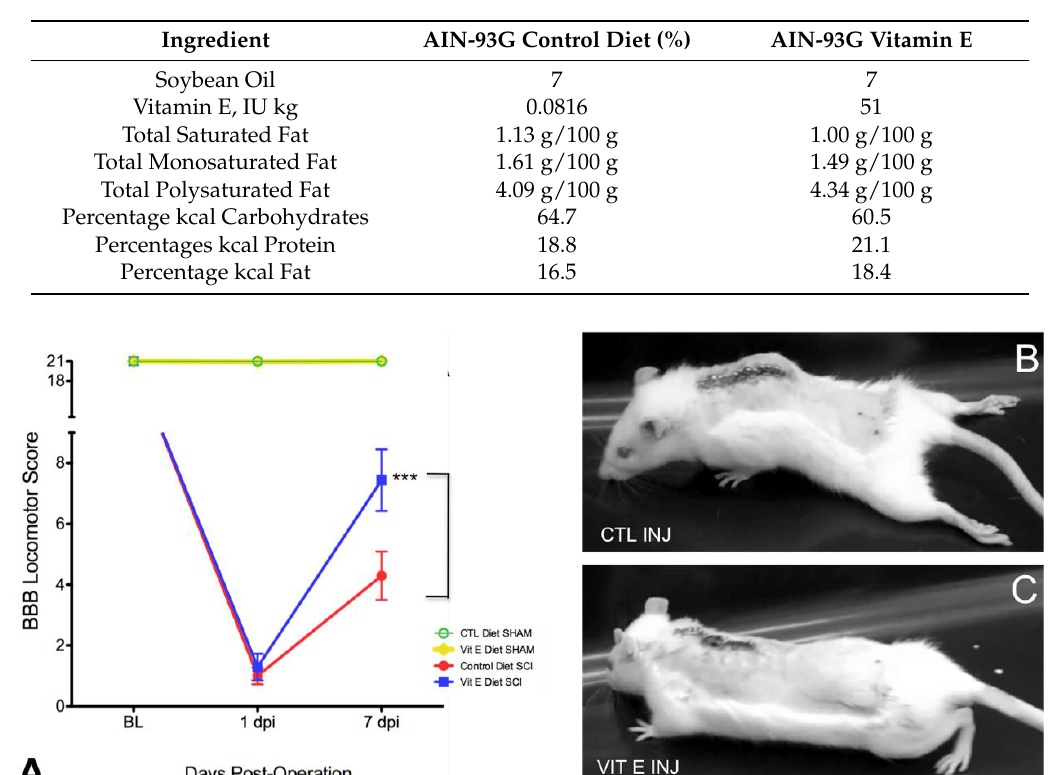
Table 1. Detailed diet composition for Control and vitamin E-Enriched Diet.